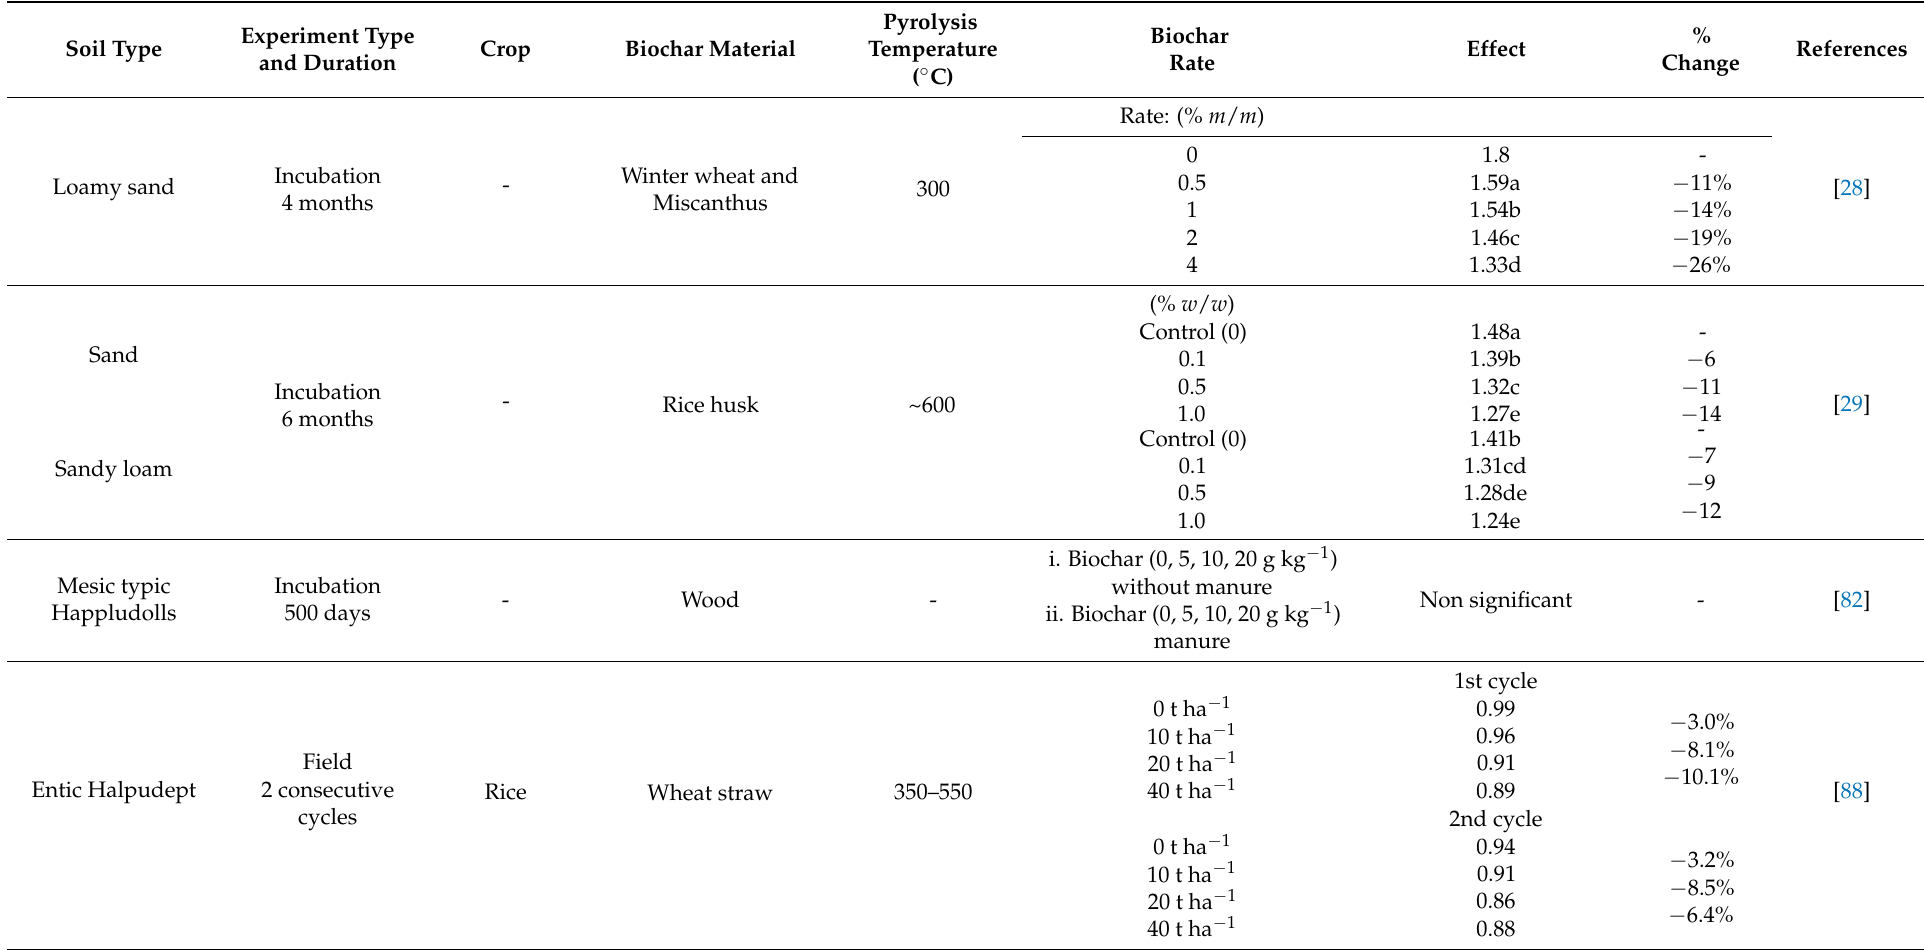
Table 5. Effect of biochar on bulk density (g/cc) of different types of soil (different letters in the same column indicating significant difference among the biochar